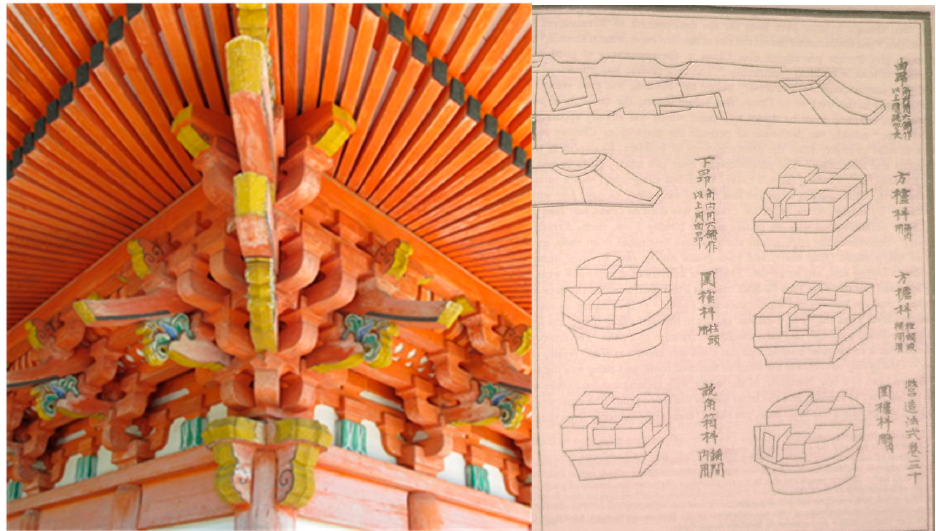
Figure 1. A Kumimono knot and a drawing from Yingzao Fashi (manual on architecture), dated 1103, from [5].